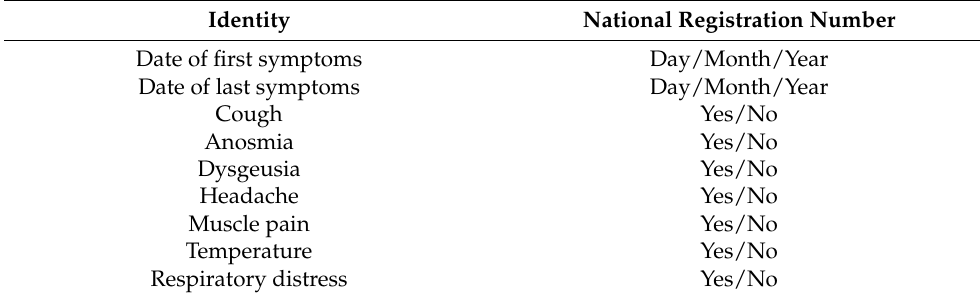
Table 1. Example of the questionnaire administered before testing. Identity National Registration Number Date of first symptoms Day/Month/Year Date of last symptoms